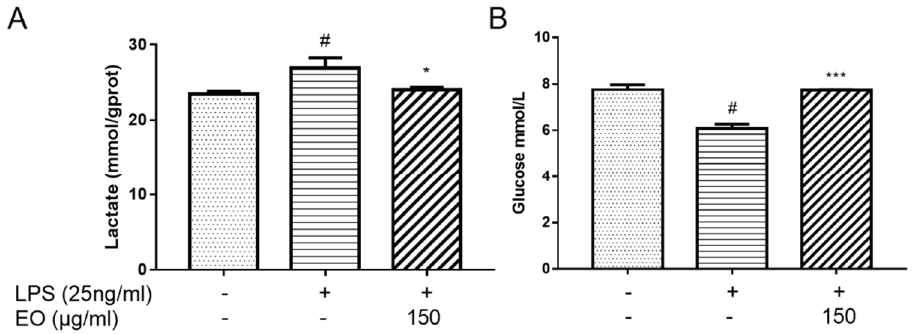
Figure 5. Measurement of the lactate ( A ) and glucose ( B ) levels in the supernatant of BV2 microglial cells. # p < 0.01 vs. control; * p < 0.05; *** p < 0.001 vs. model group. All tests were performed in triplicate.